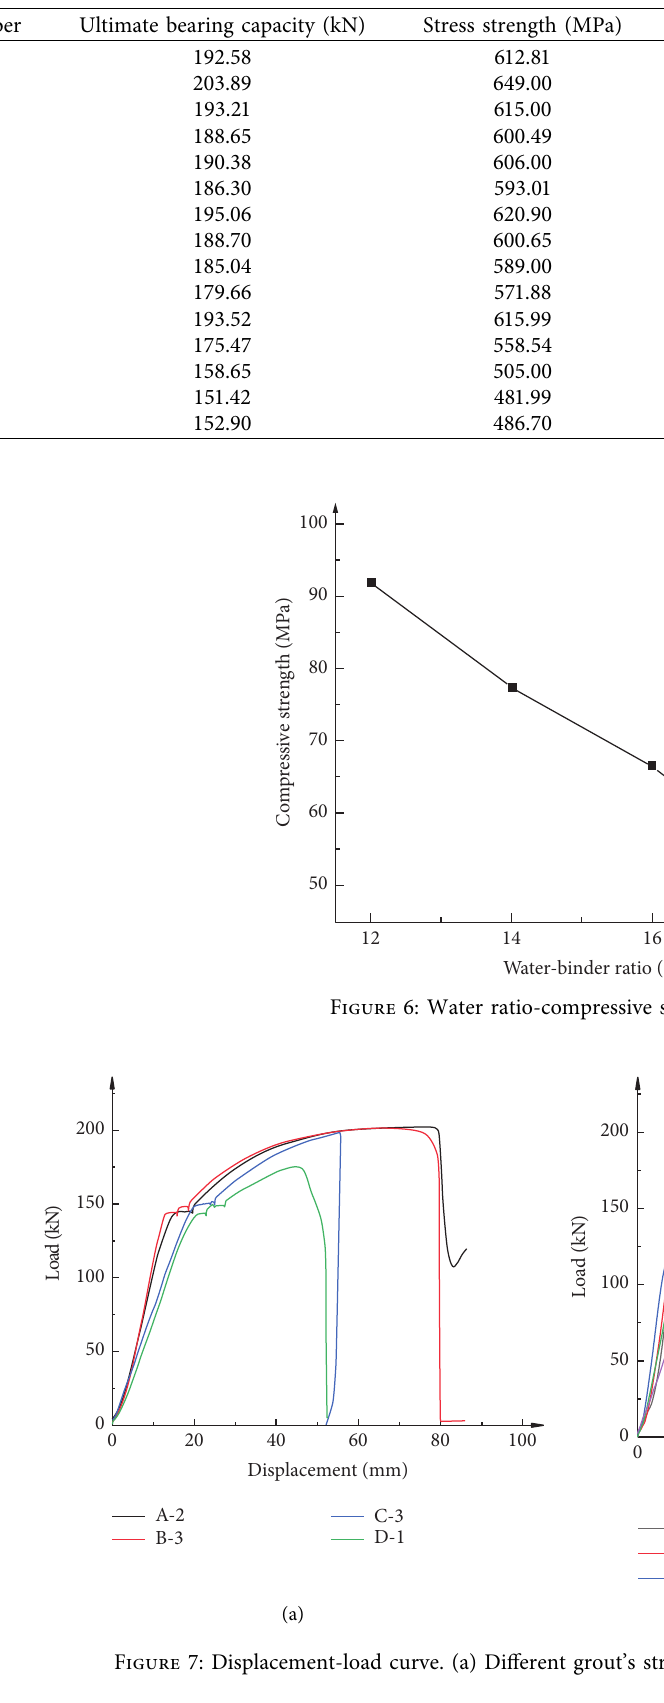
Table 4: Specimen loading test